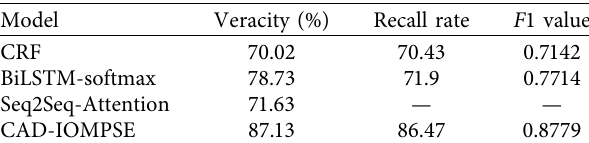
Table 3: Test performance comparison of different